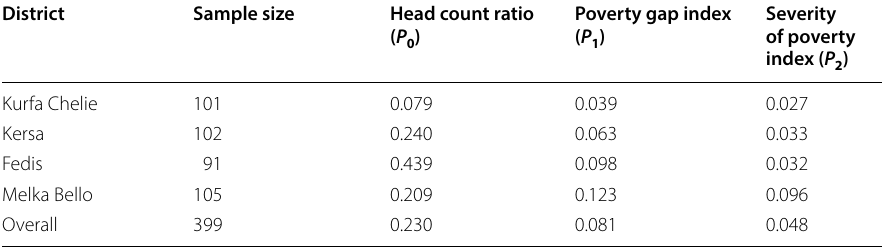
Table 3 Households’ poverty gap and severity District Sample size Head count ratio